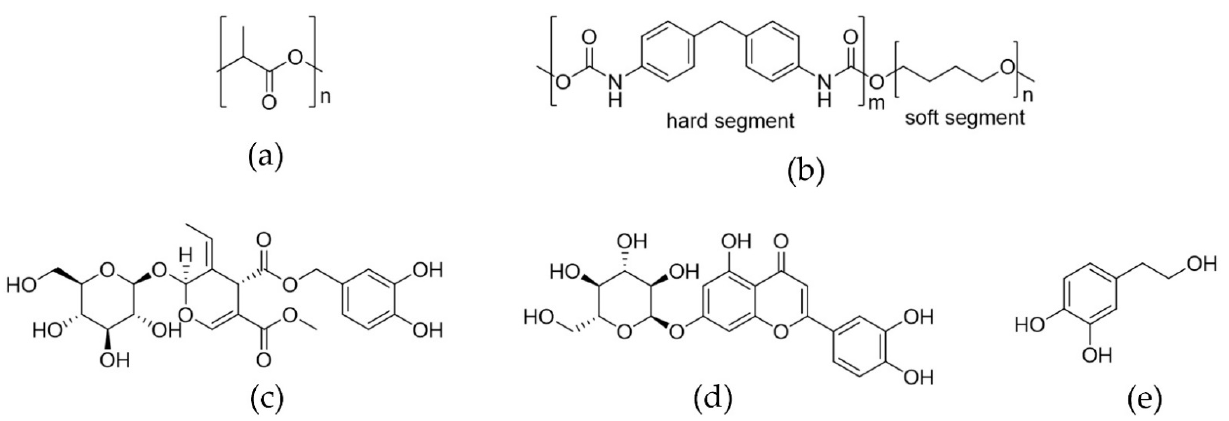
Figure 9. Chemical structure of the polymers ( a ) PLA and ( b ) TPU; and the main constituents of OLE extract ( c ) oleuropein, ( d ) luteolin-7-glucoside, and ( e ) hydroxytyrosol. According to Section 3.1, TPU and PLA swelled after the supercritical treatment.